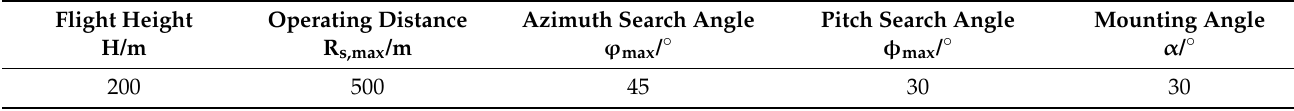
Table 2. The parameter table of UAV reconnaissance payload.